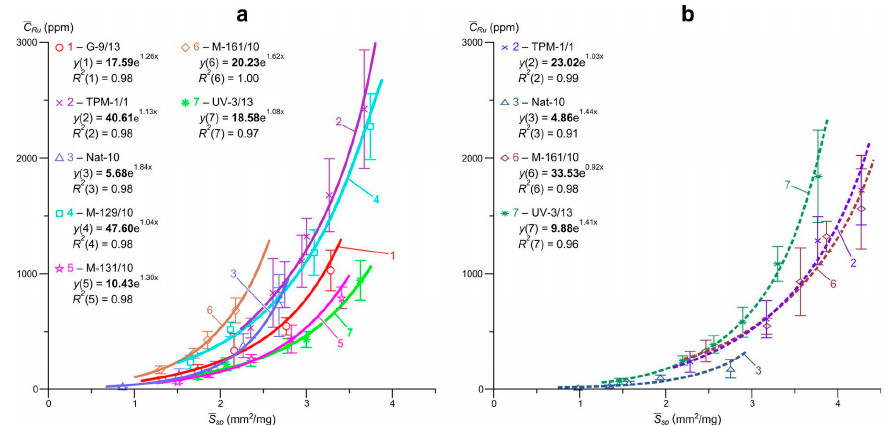
Figure 6. Dependences of the average content of evenly distributed palladium on the specific surface area of an average crystal in size fractions of arsenopyrite ( a ) and pyrite ( b ) from vein, streaky-vein and veinlet-disseminated ores of the Natalkinskoe deposit.